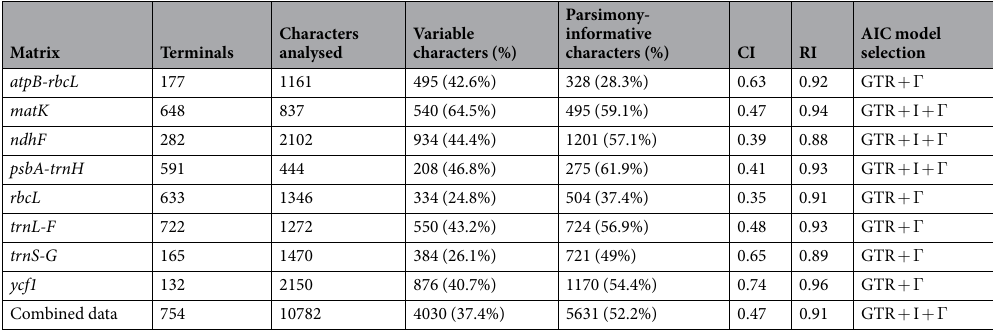
Table 2. Descriptive statistics and best-fitting substitution model for each of the eight chloroplast regions and the concatenated datasets. CI = ensemble consistency index; RI = ensemble retention